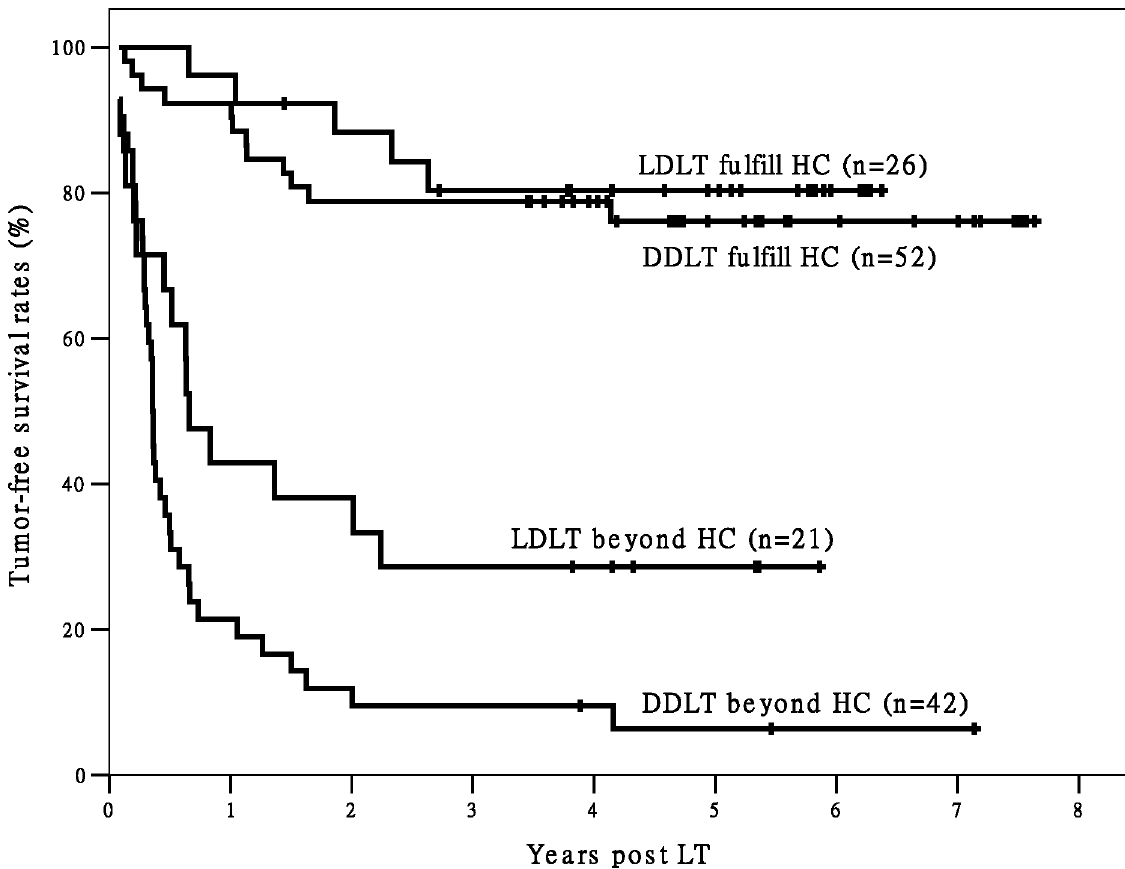
Figure 2. The survival curves of post-LT TFS of recipients. There is a significant difference in TFS between recipients fulfilling Hangzhou criteria and patients exceeding Hangzhou criteria (P , 0.05). There is no significant difference in TFS between different transplant types within Hangzhou criteria (P . 0.05). However, there is significant difference in TFS between different transplant types beyond Hangzhou criteria (P=0.024). Abbreviation: TFS, tumor-free survival; HC, Hangzhou criteria; LDLT, living donor liver transplantation; DDLT, deceased donor liver transplantation; LT, liver transplantation;